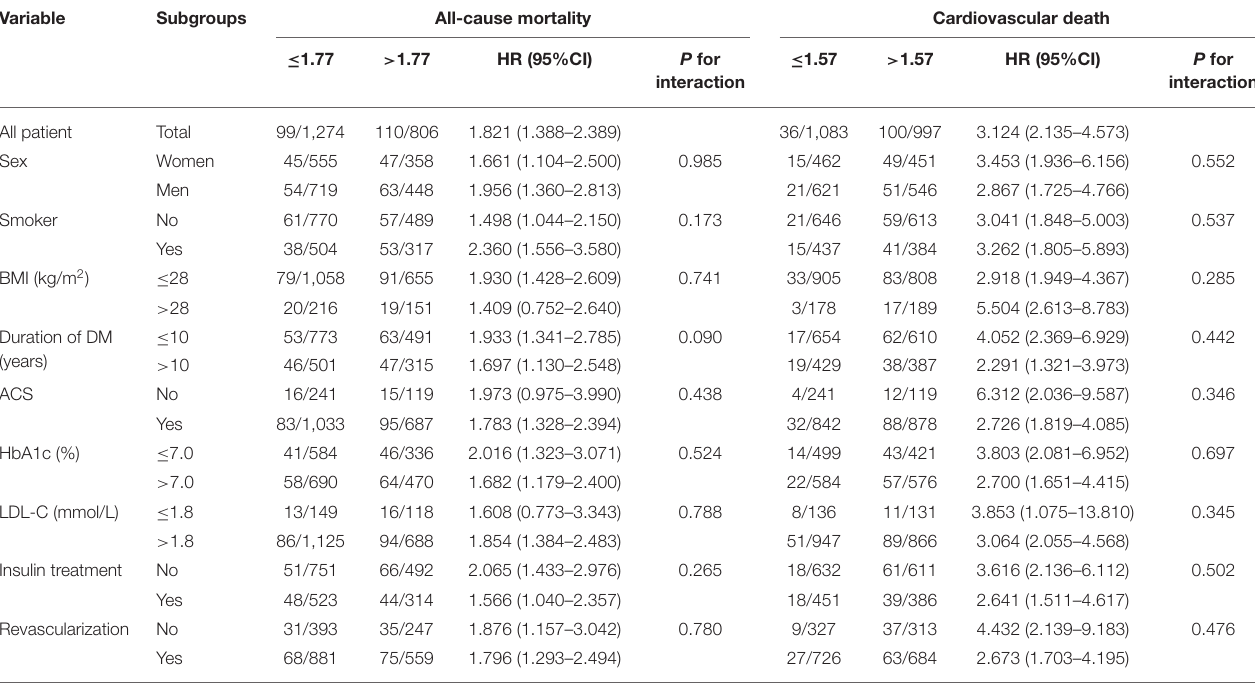
TABLE 5 | All-cause mortality and cardiovascular death in the various patient subgroups. Variable